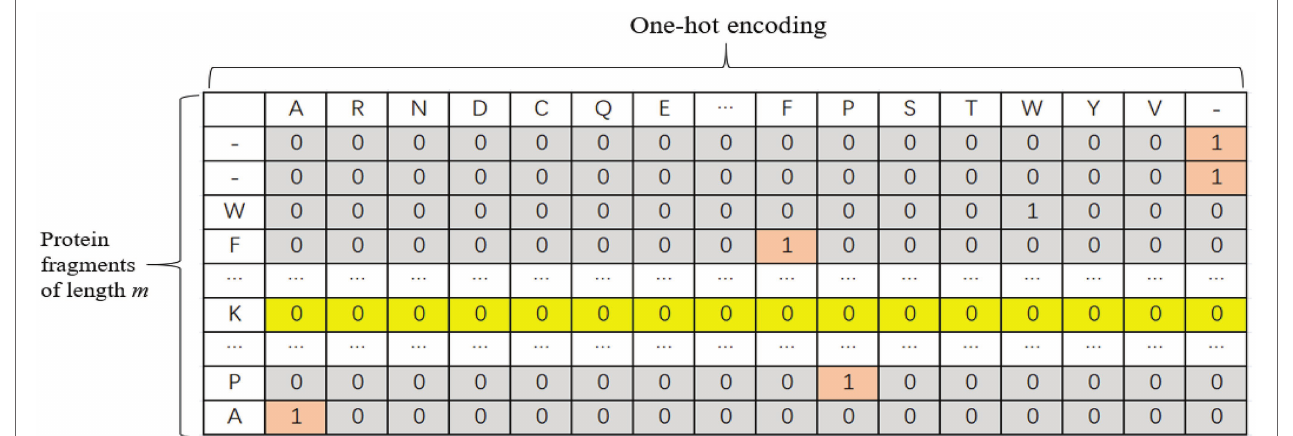
FIGURE 1 | Schematic diagram of one-hot encoding of protein